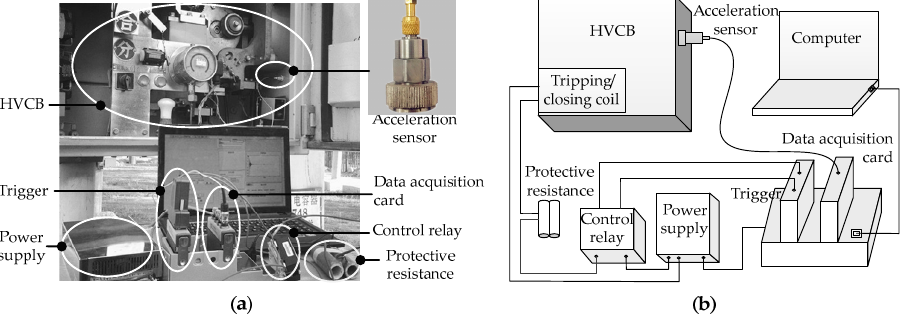
Figure 1. ( a ) The vibration signal acquisition system of HVCBs; ( b ) The block diagram of the acquisition system. acquisition